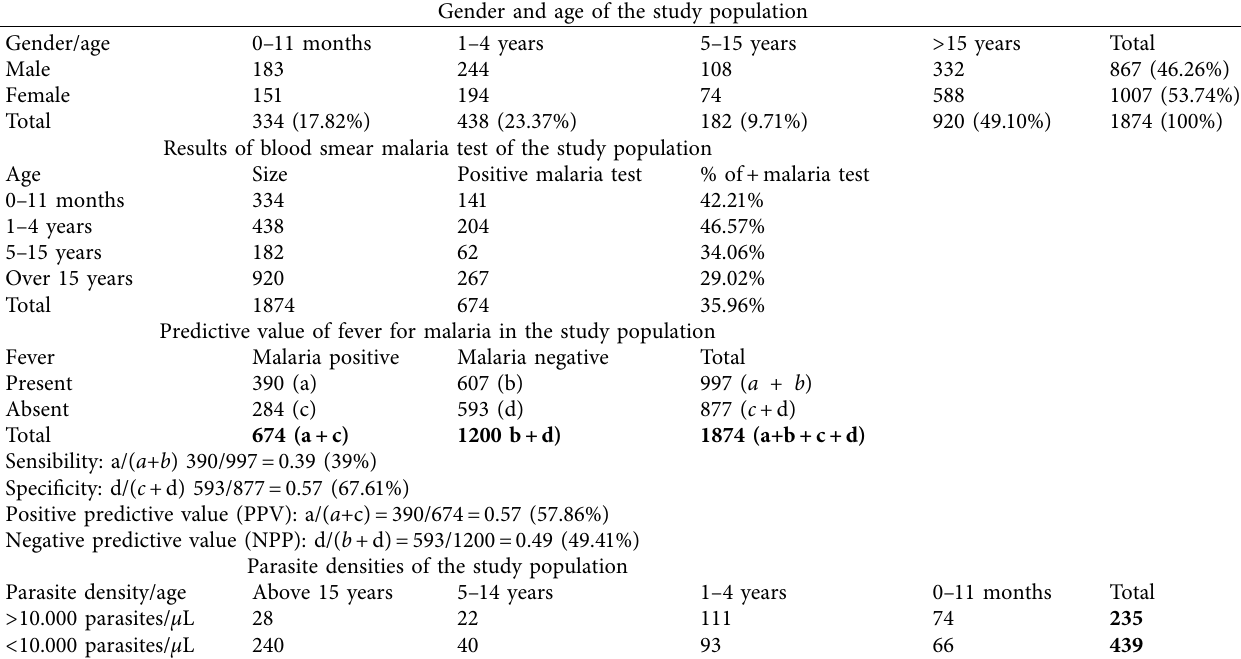
Table 1: Gender, age, and malaria test outcomes of the study